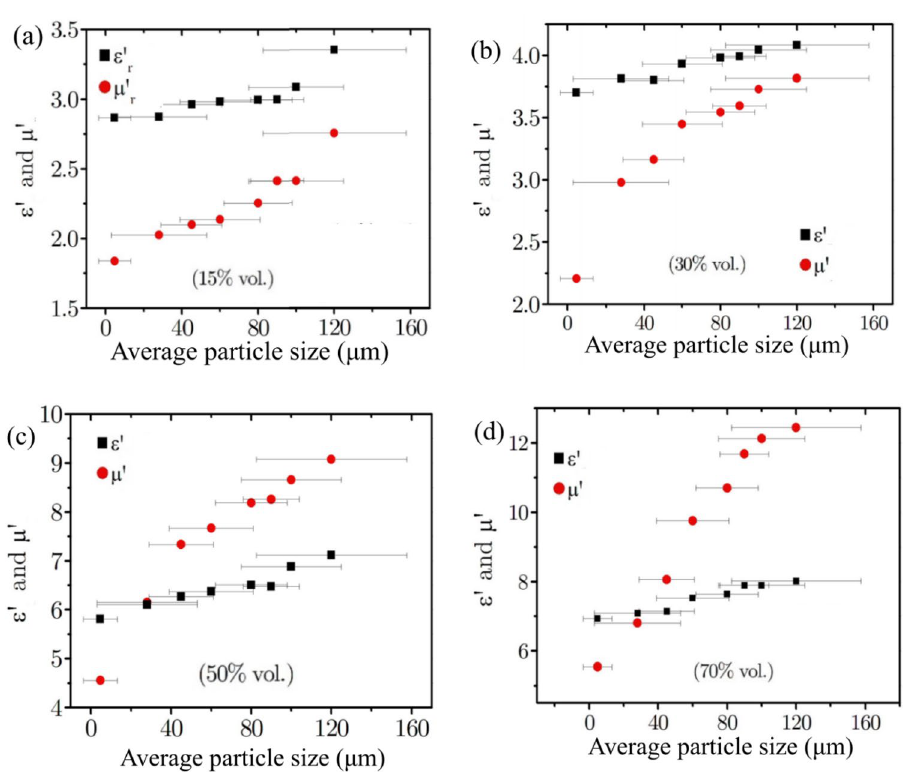
Figure 2. Plots of the relative real permittivity ( ε ˊ ) and permeability ( μ NiZn ferrite particle size for a NiZn ferrite-PTFE composite with ( a ) 15% vol., ( b ) 30% vol., ( c ) 50% vol. and ( d ) 70% vol. loading of ferrite material. The average particle size and uncertainty were deduced from laser diffraction